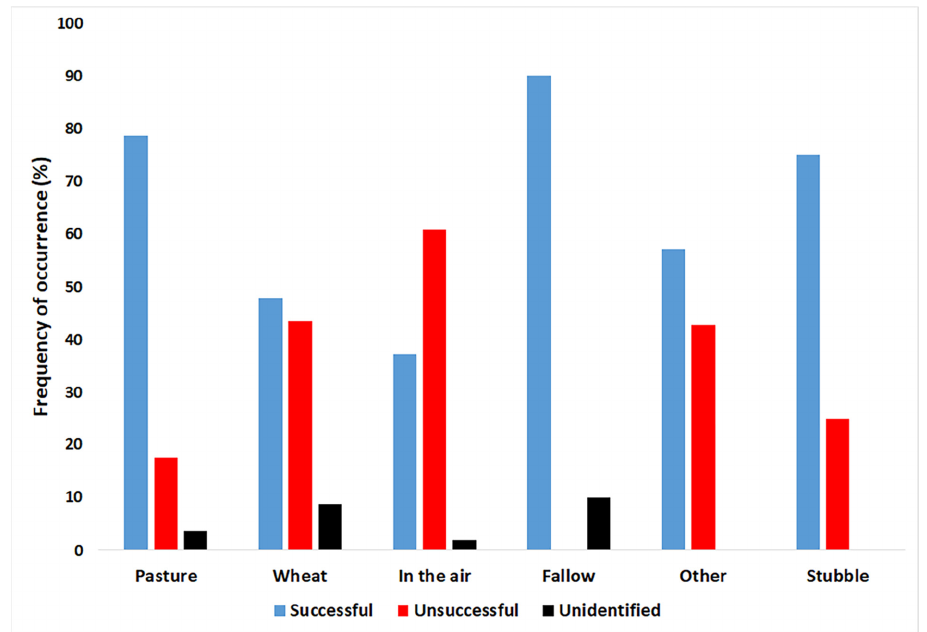
Figure 3. Results of the foraging of non-territorial Eastern Imperial Eagles in different habitat types.